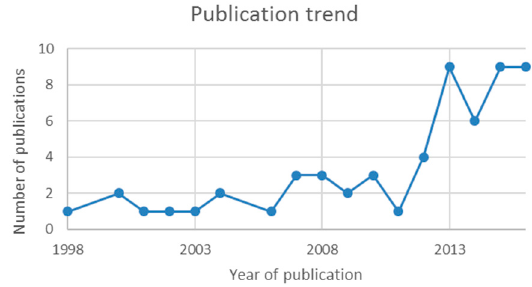
Figure 2. Number of annual publications.